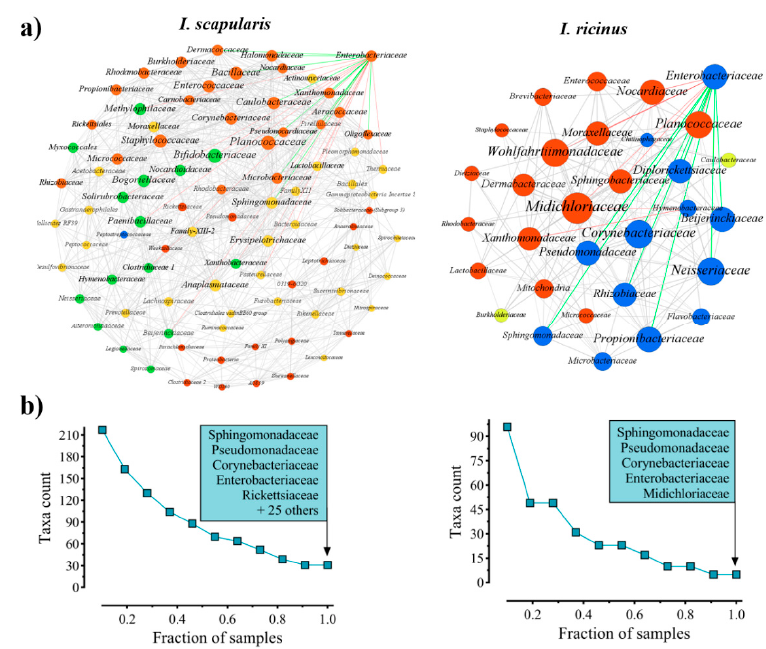
Figure 1. Interactions and ubiquitous bacterial families on the gut microbiota of I. scapularis and I. ricinus nymphs. ( a ) Co-occurrence bacterial networks obtained from 16S sequences. Nodes correspond to taxa (family level), and connecting edges indicate significant ( p < 0.01) and strong positive or negative correlations (SparCC > 0.7 or < − 0.7). Only nodes with at least one significant